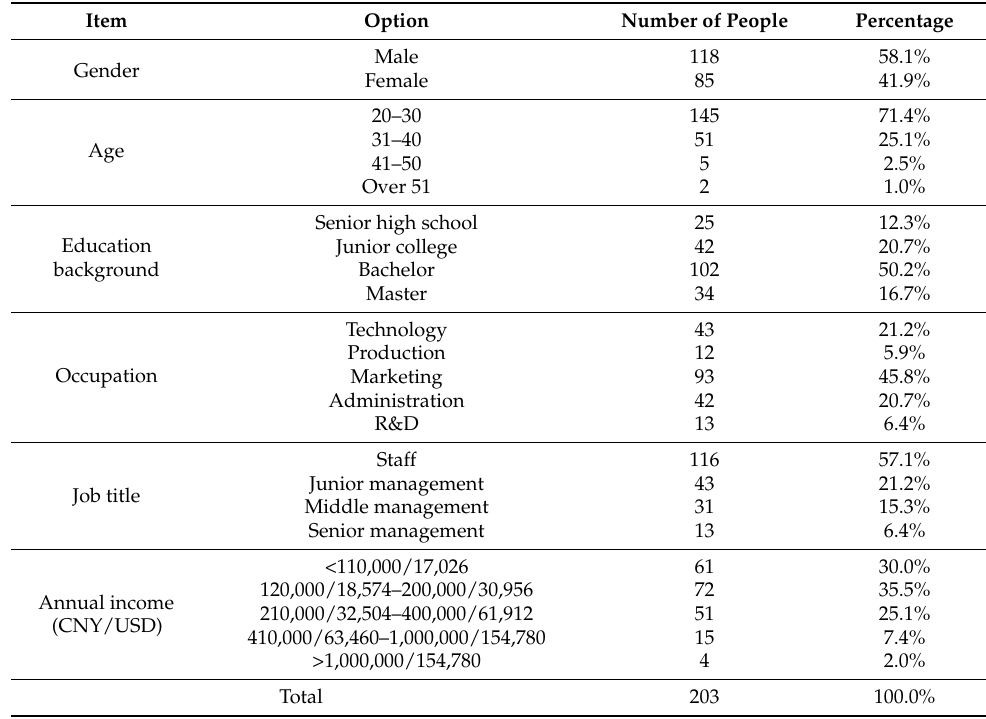
Table 2. Statistics of participants’ basic information.